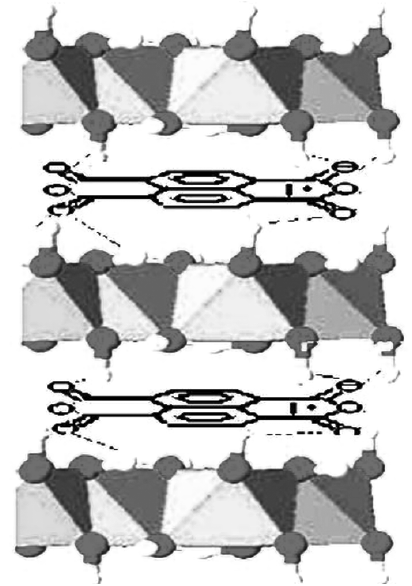
Figure 8. Inclusion of the NTCDA 1– into layered double hydroxide of the bayerite